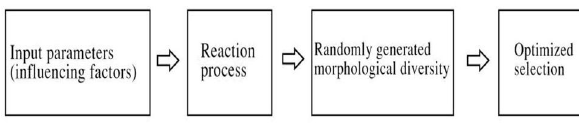
Figure 3: Non-linear morphology generation process